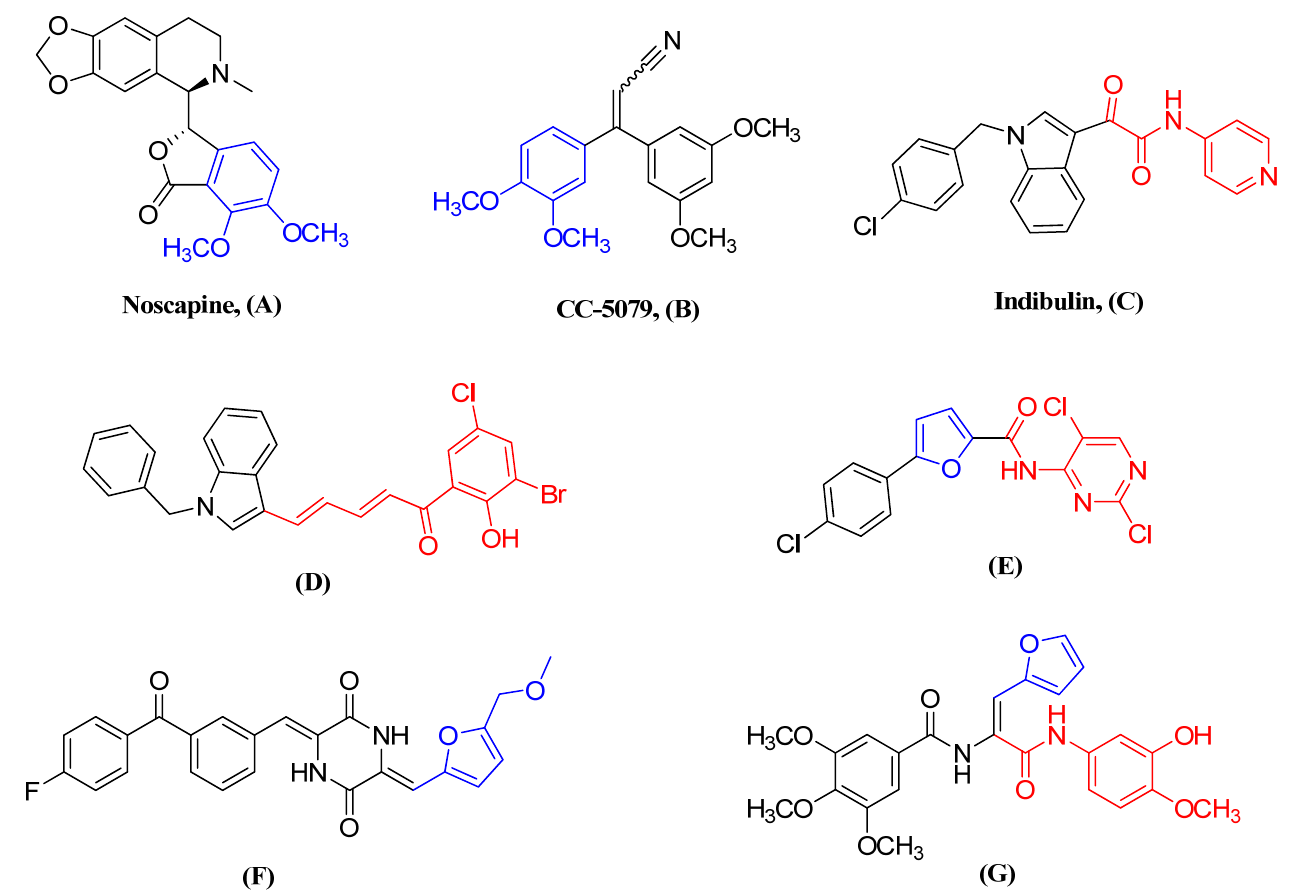
Figure 1. Colchicine binding site ligands of recognized medications in clinical trials ( A – C ), dienone analogue ( D ) and furan-based anticancer derivatives ( E – G ).